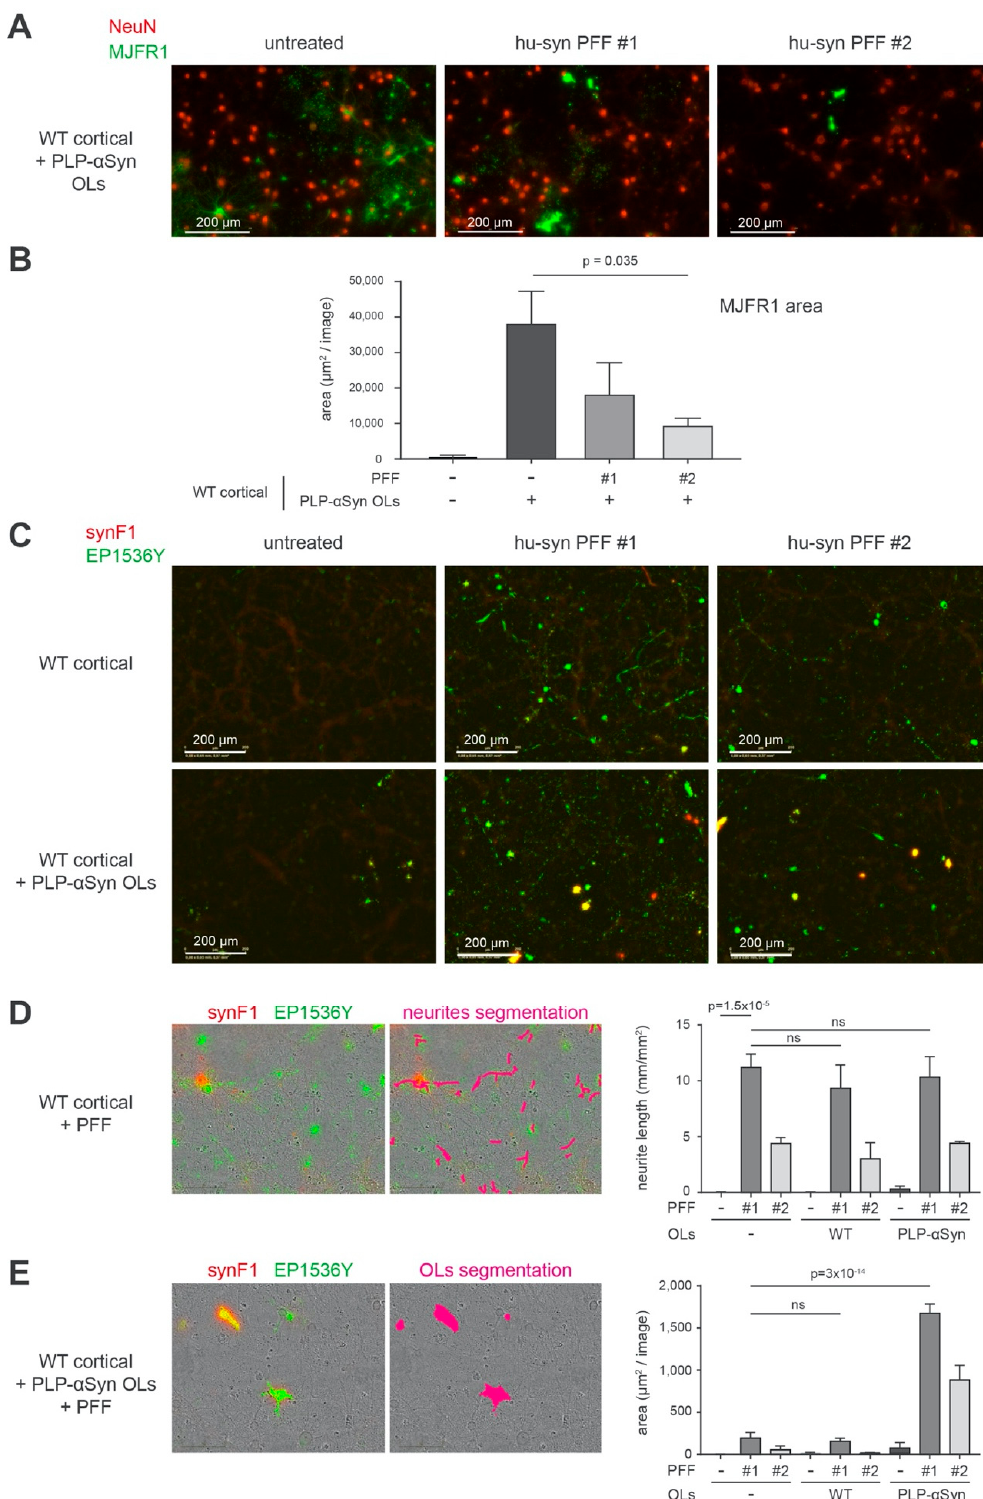
Figure 6. Aggregation of human α -syn does not spontaneously take place on OLs from PLP- α Syn mice but can be experimentally seeded by challenging with PFFs. ( A ) Representative immunofluorescence imaging of neurons (NeuN, red) and human α -syn (MJFR1, green) in primary cortical cultures from WT mouse supplemented with OLs from PLP- α Syn mice, untreated ( left ) or challenged with human α -syn PFF of type 1 ( middle , PFF #1) or type 2 (right, PFF #2). Pictures were taken four weeks